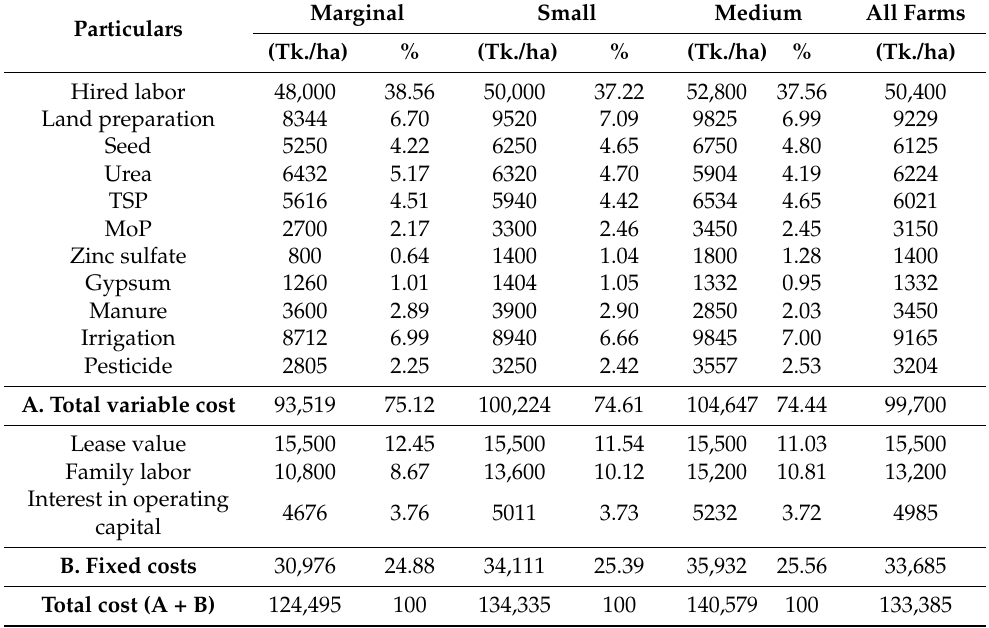
Table 3. Per hectare costs of maize